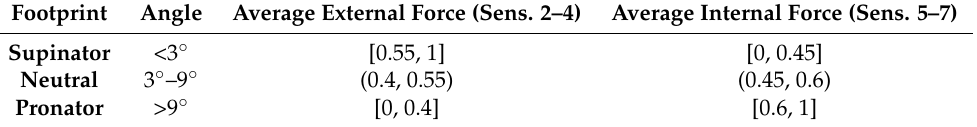
Table 2. Relations between rear-foot eversion angles and the instrumented insole’s sensors for the real-time testing